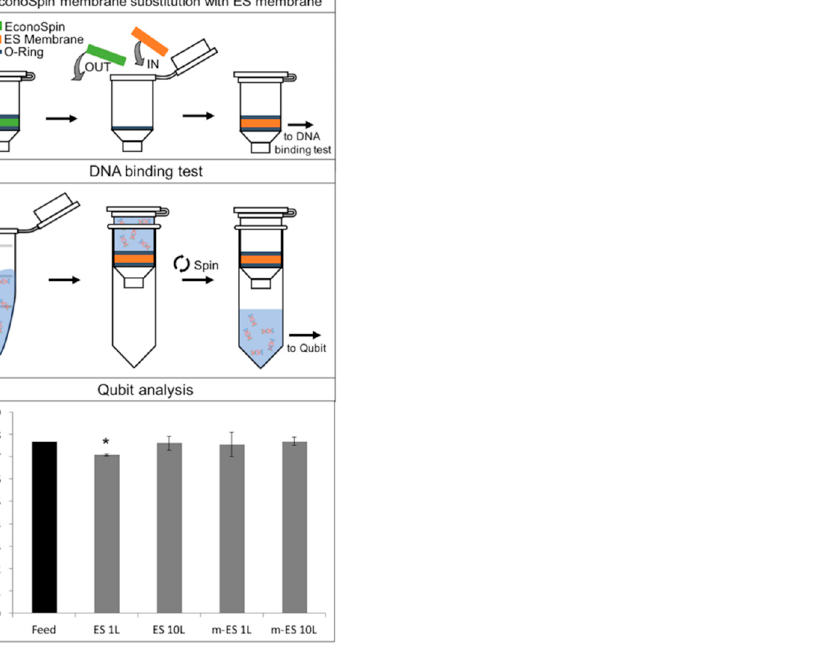
Figure 6. ( A ) Schematic describing the substitution of the membrane in a column device with the engineered electrospun membranes; ( B ) schematic describing the DNA binding test procedure; ( C ) DNA concentration in water before (control) and after permeation through modified and unmodified electrospun PLA membranes. * Indicates statistically significant differences ( p < 0.01) when analyzed by